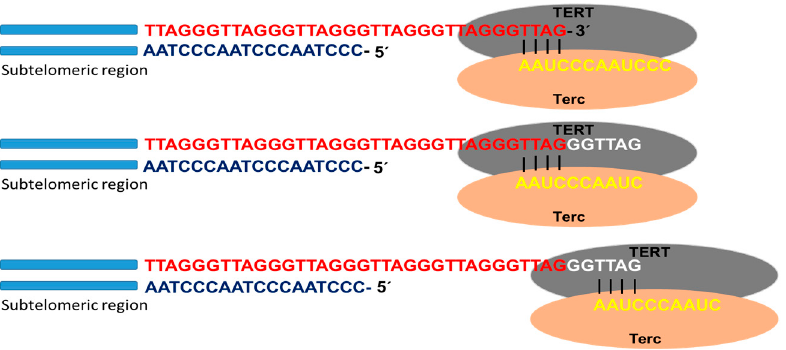
Figure 2. Telomerase activity. Schematic representation of telomere replication by telomerase, as well as the catalytic subunit with reverse transcriptase action (TERT) and the subunit containing the RNA template for telomere replication (Terc). Once the template RNA hybridizes with the telomeric DNA sequence of the G chain, at the 3 ′ -OH end, the telomere polymerization process begins. Once the hexanucleotide sequence is added, the enzyme performs a translocation movement, and telomere elongation continues.